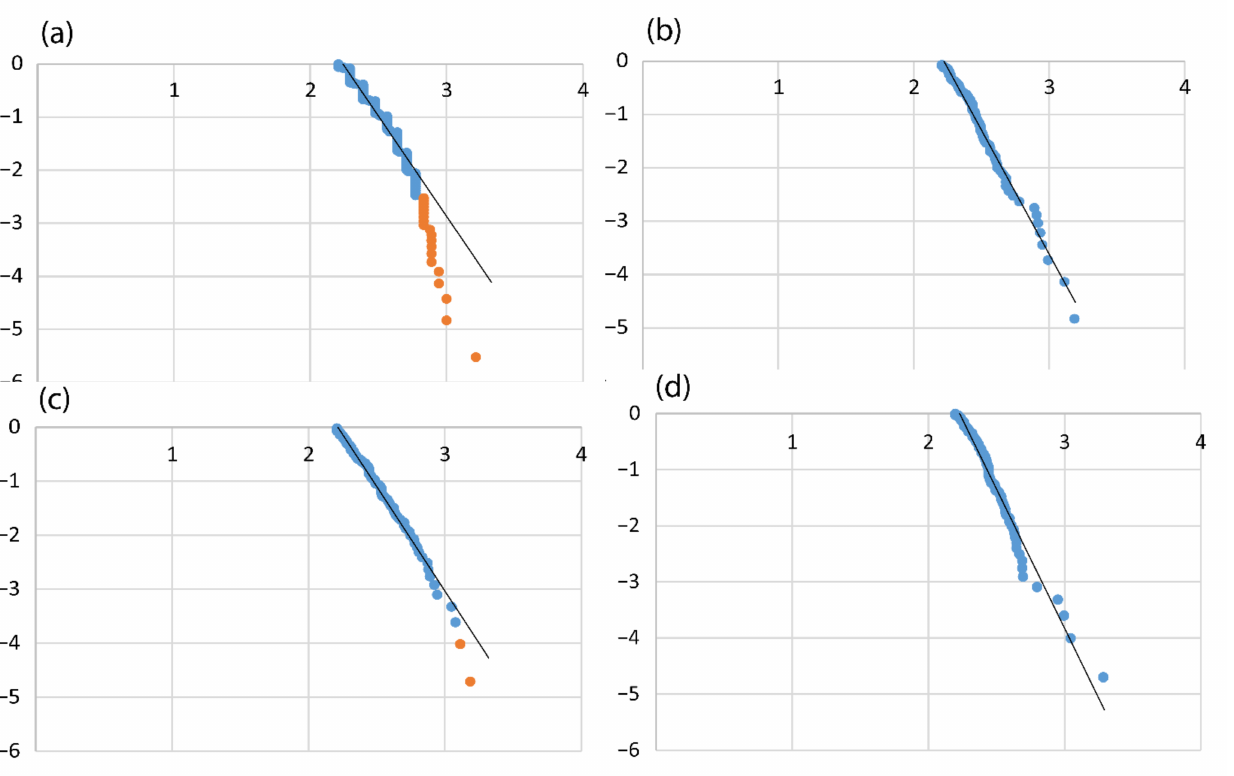
Figure 2. Empirical CDFs of daily precipitation amounts (station observations) straightened on the coordinate axis of the Pareto distribution, and a linear regression line corresponding to the Pareto function. ( a ) Fruholmen Fyr, ( b ) Kandalaksha, ( c ) Teriberka, ( d ) Arkhangelsk. In all cases, R 2 > 0.96 for basic distribution (blue dots). The yellow dots are deviations from the Pareto function (the so-called